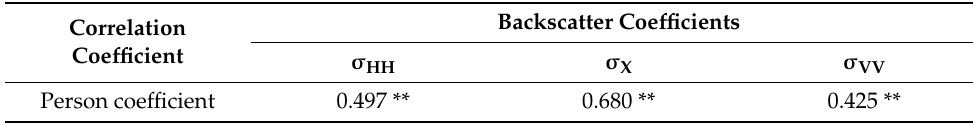
Table 3. AGB backscatter coefficients correlation